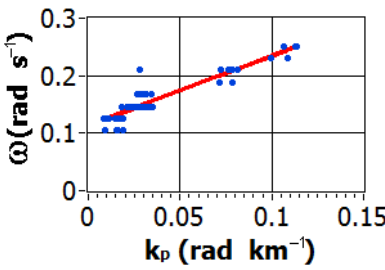
Figure 14. Derived dispersion relation (blue) including a linear fit (red). For the calculation the projected wavelength on the orbiter- lander connecting line and the related angular frequencies at which the maximum cross-power occurs have been used.